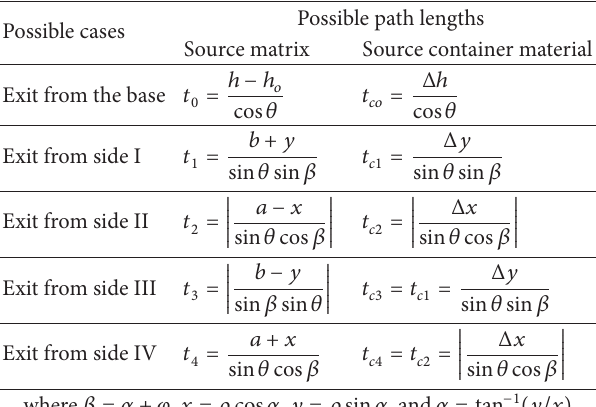
Table 3: The possible path lengths inside the source matrix. Azimuthal angles conditions